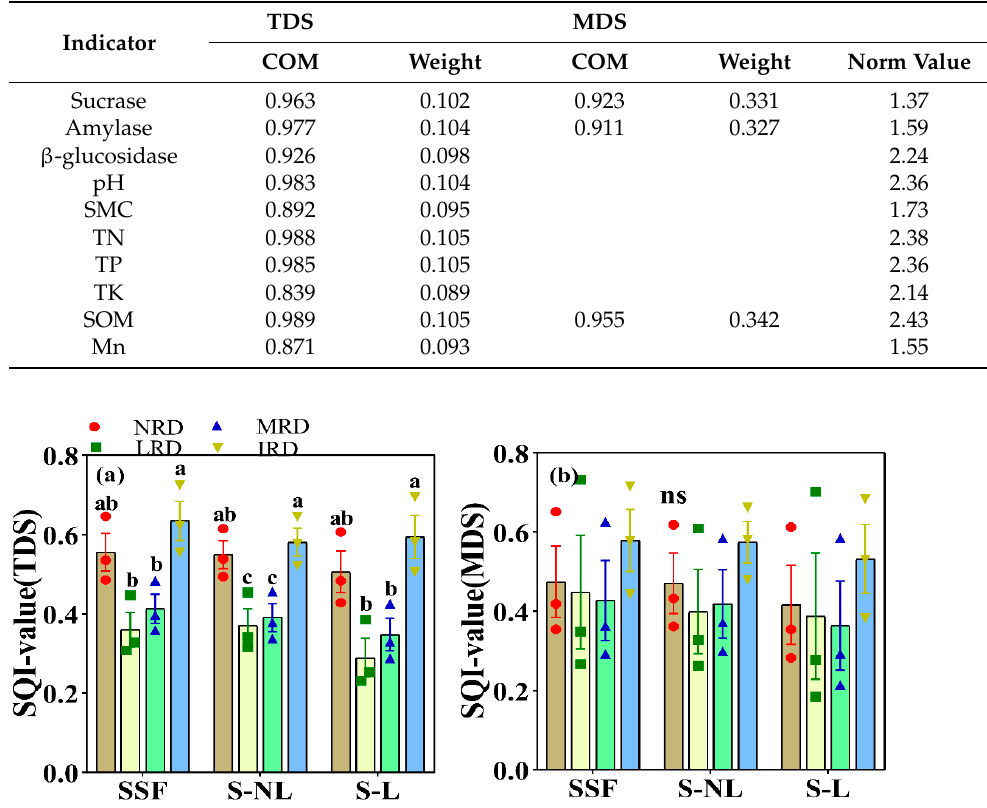
Figure 5. Score of soil quality index based on MDS and TDS in the study: soil quality index (SQI), total data set (TDS), minimum data set (MDS), standard scoring function ( SSF ), linear scoring function ( S L ) and nonlinear scoring function ( S NL ). Different small letters represent significant differences between different soil layers of the same rocky desertification grade ( p < 0.05), ns: not significant. ( a ) Soil quality index according to the total data set and ( b ) Soil quality index according to the minimum data set.